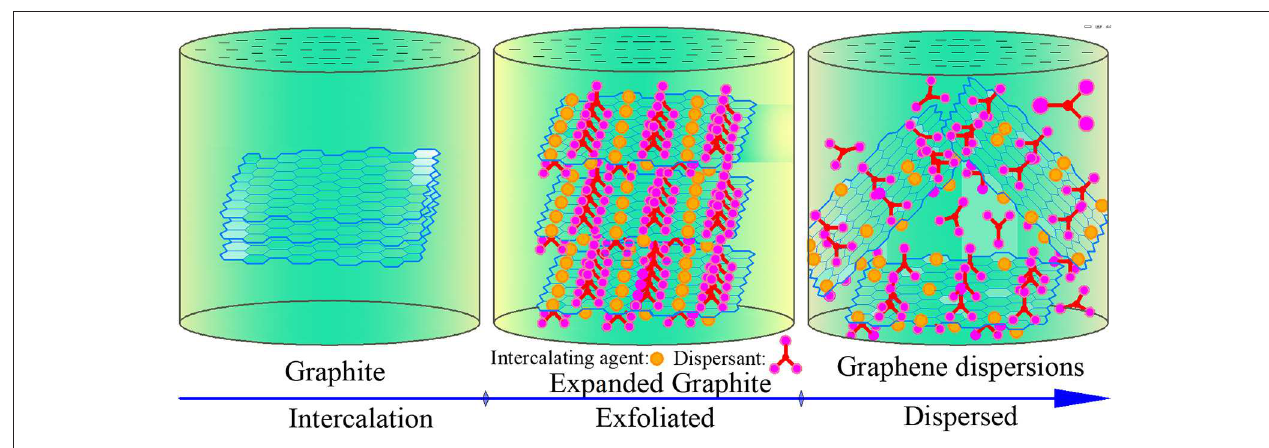
FIGURE 1 | Microstructure diagram of graphene exfoliation and dispersion by stripping graphite in liquid phase.